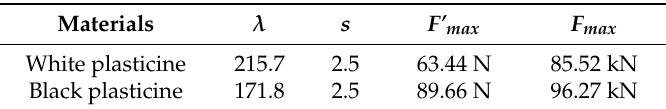
Table 5. Extrapolation of the maximum forces occurring in cross rolling of 40 mm diameter balls, based on the test results of the model process.